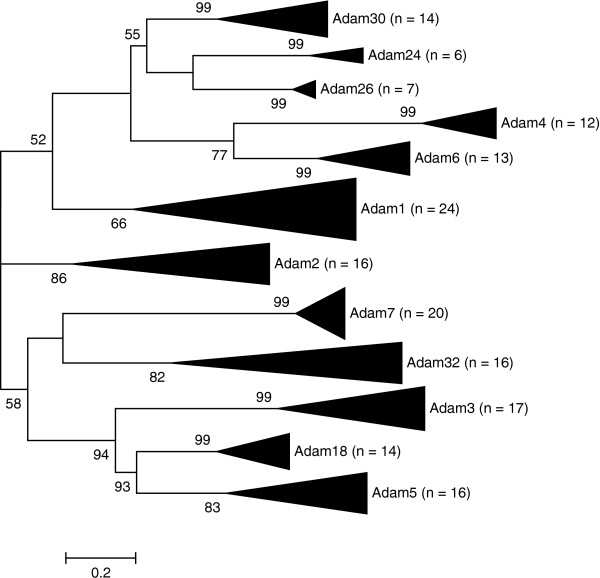
Sperm Adam molecular phylogeny supporting Adam sequence orthology. The WAG model of protein evolution with G, the gamma distribution shape parameter, and I, invariant sites, was selected for the phylogenetic reconstruction. The model was selected based on its likelihood and AIC (akaike information criterion) value (Additional file 1: Table S3).